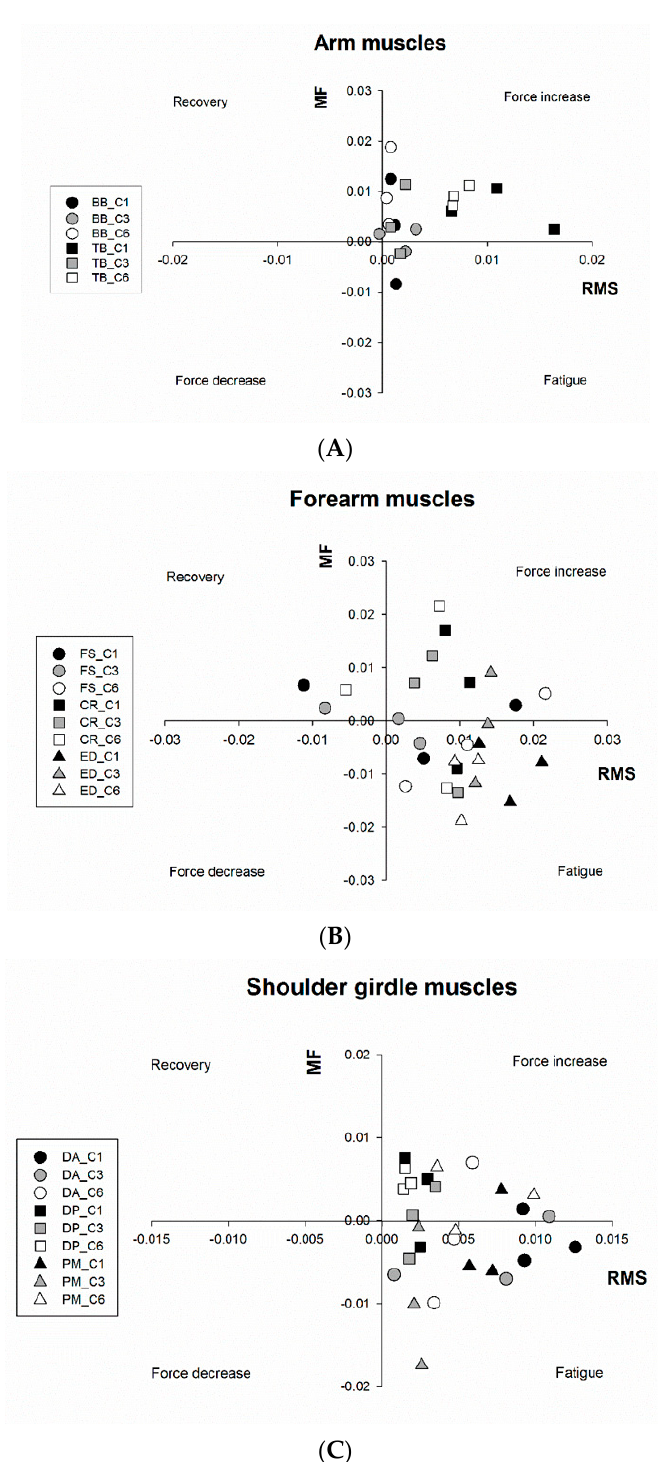
Figure 4. Application of the joint analysis of the sEMG spectrum (ordinate axis) and amplitude (abscissa axis) to the most demanding curves (C1, C3, and C6) with results separated per body segments. ( A ): Arm Muscles (BB: biceps brachii; TB: triceps brachii); ( B ): Forearm muscles (FS: flexor digitorum superficialis; CR: carpi radialis; ED: extensor digitorum communis); ( C ): Shoulder girdle muscles (DA: anterior part of the deltoid; DP: posterior part of the deltoid; PM: pectoralis major). Note: The results of individual linear regressions, for each curve and round, are shown in Supplementary Materials (Tables S1 and